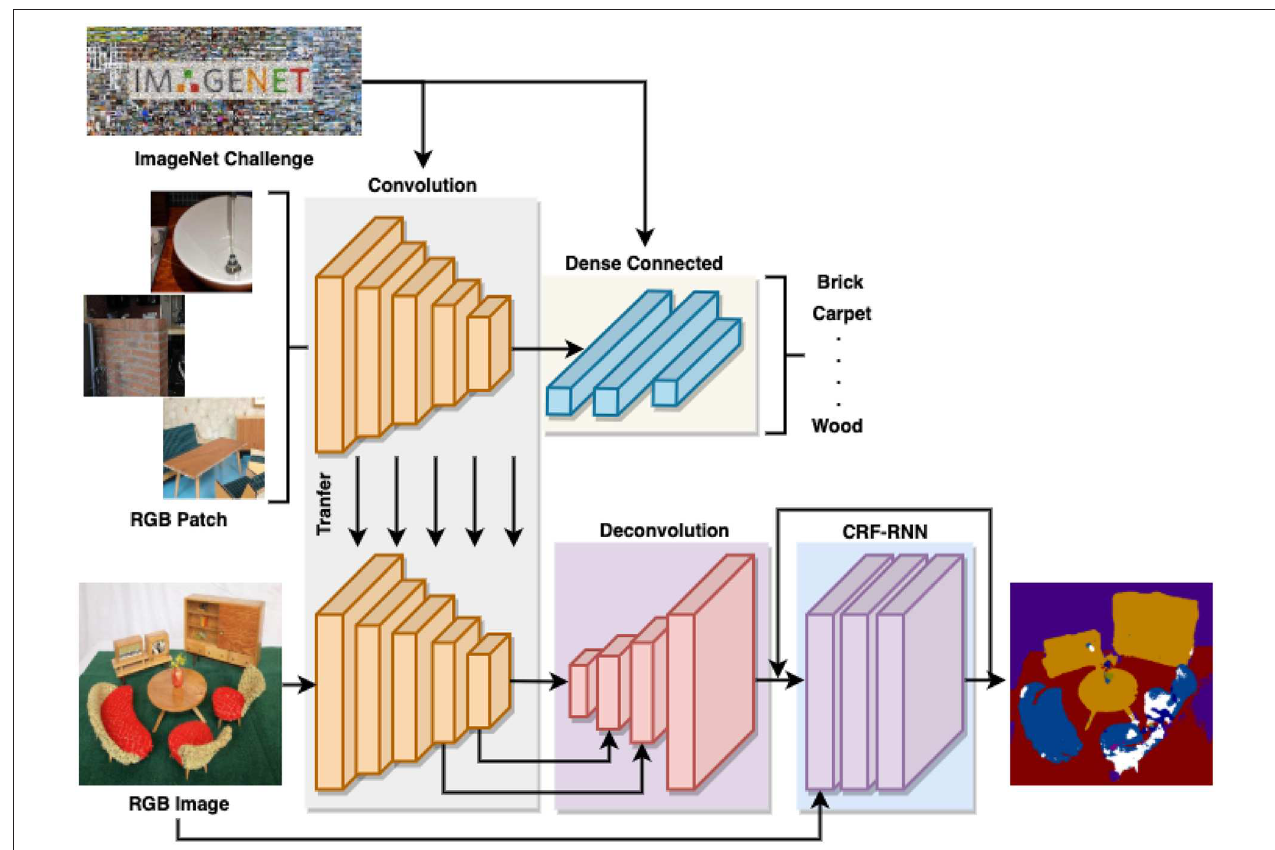
FIGURE 4 | The architecture of the proposed network and transfer learning.